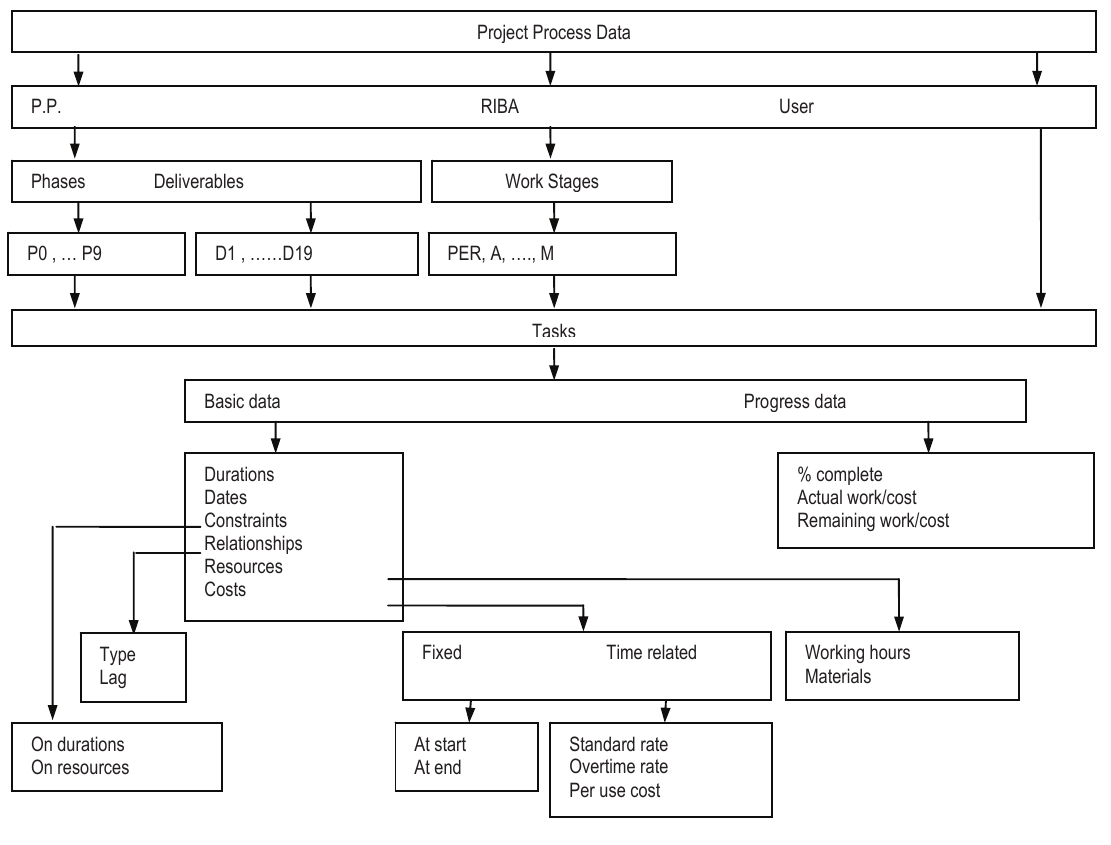
Figure 3. Planning and control data